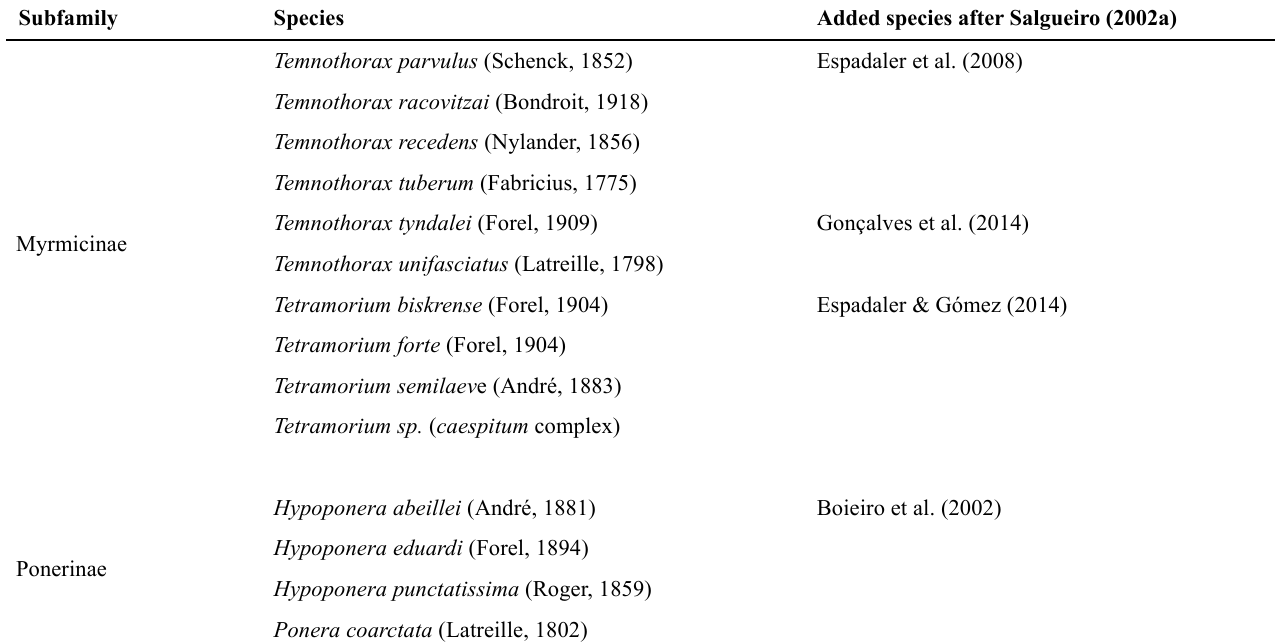
Table 3 . Complete checklist of continental Portuguese ant fauna, combining that of Salgueiro (2002a) and posterior additions. Nomenclatural changes proposed after 2002 have been applied to the names.